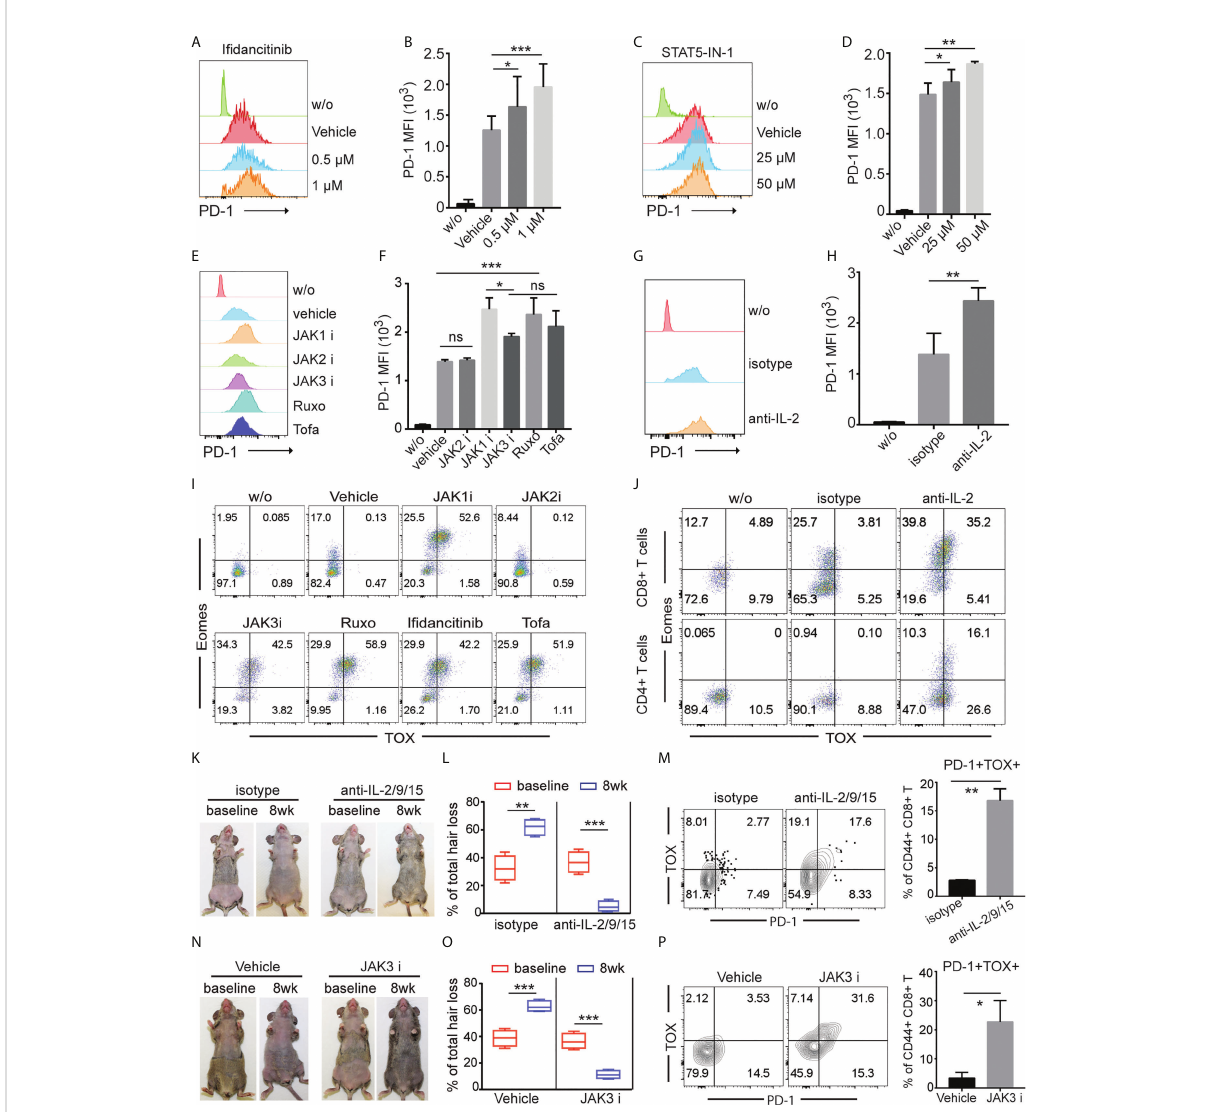
FIGURE 5 g c cytokines regulated effector T cell exhaustion. (A) to (J) T cells from C3H/HeJ mice without AA were stimulated with 500 ng/ml anti-CD3 in the presence of indicated regents in vitro for 4 (d) (A) and (B) The expression of PD-1 on CD8 + T cells was measured by FACS after treated with increasing dose of I fi dancitinib. *P < 0.05, ***P < 0.001 (one-way ANOVA). (C) and (D) The expression of PD-1 on CD8 + T cells was measured by FACS after treated with increasing dose of STAT5 inhibitor. *P < 0.05, ***P < 0.001 (one-way ANOVA). (E) and (F) The expression of PD-1 on CD8 + T cells was measured by FACS after treated with 1 µM of JAK1i (Itacitinib), JAK2i (Fedratinib), JAK3i (Ritlecitinib), JAK1/2-selective inhibitor Ruxolitinib (Ruxo), or pan- JAK inhibitor Tofacitinib (Tofa). ns indicates not signi fi cant, *P < 0.05, ***P < 0.001. P values were determined using one-way ANOVA followed by Brown-Forsythe test. (G) and (H) The expression of PD-1 on CD8 + T cells was measured by FACS after treated with 20 µg/ml IL-2 neutralizing mAbs. **P < 0.01. (Unpaired Student t test). (I) The expression of Eomes and TOX in CD8 + T cells was measured by FACS after treated with 1µM of JAK1i (Itacitinib), JAK2i (Fedratinib), JAK3i (Ritlecitinib), JAK1/2-selective inhibitor Ruxolitinib (Ruxo), I fi dancitinib, or pan-JAK inhibitor Tofacitinib (Tofa). (J) The expression of Eomes and TOX in CD8 + T cells was measured by FACS after treated with 20 µg/ml IL-2 neutralizing mAbs and isotype control mAbs. (K) to (M) C3H/HeJ mice with AA were treated with a combination of IL-2 neutralizing mAbs, IL-9 neutralizing mAbs and IL-15 neutralizing mAbs or isotype for 8 weeks. (K) Representative images of anti-IL2/9/15 or isotype treated C3H/HeJ mice before or after 8 weeks treatment. (L) Percentage of skin hair loss or regrowth is shown before and after treatment. **P < 0.01, ***P < 0.001 (Unpaired Student t test). The expression of PD-1 on CD8+ T cells was measured by FACS after treated with 20 µg/ml IL-2/9/15 neutralizing mAbs. **P < 0.01. (Unpaired Student t test). The results are representative of two separate experiments. (N) to (P) C3H/HeJ mice with AA were treated with Ritlecitinib or vehicle systemically for 8 weeks. (N) Representative images of Ritlecitinib or vehicle treated C3H/HeJ mice before or after 8 weeks treatment. (O) Percentage of skin hair loss or regrowth is shown before and after treatment. ***P < 0.001 (Unpaired Student t test). (P) The frequency of PD-1+TOX+CD44+CD8+ T cells within SDLNs were measured with mice that were systemically treated with Ritlecitinib or vehicle for 8 weeks. *P < 0.05. (Unpaired Student t test). The results are representative of two separate experiments.